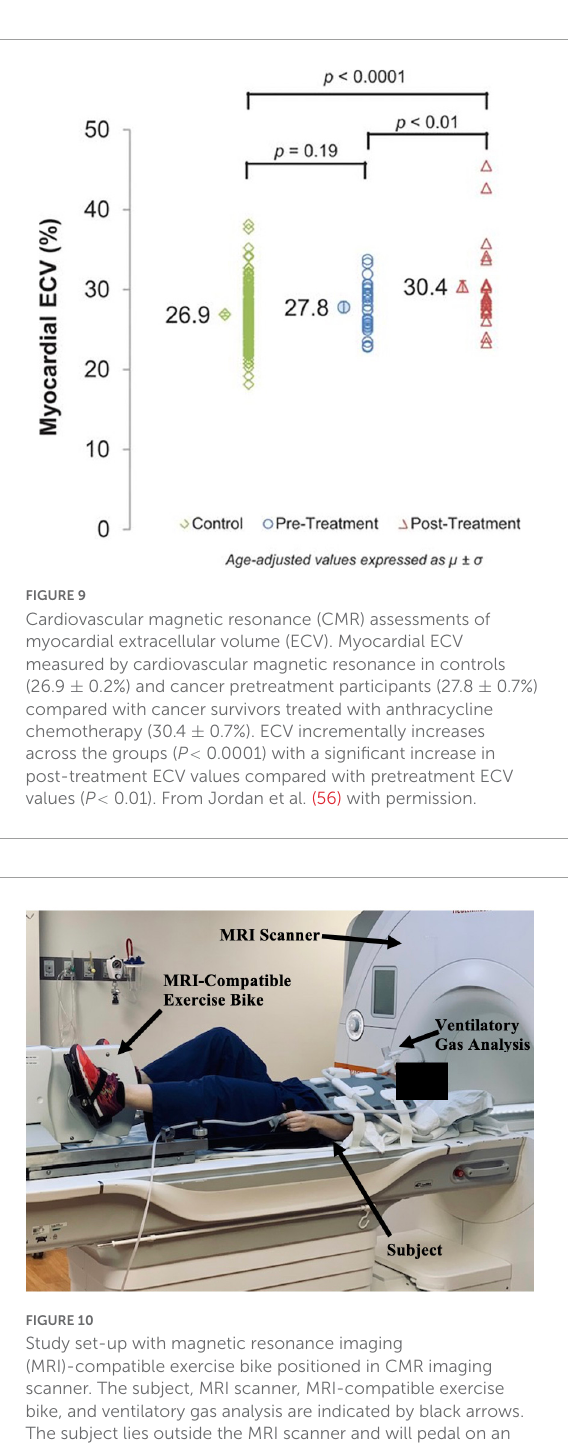
FIGURE10 Study set-up with magnetic resonance imaging (MRI)-compatible exercise bike positioned in CMR imaging scanner. The subject, MRI scanner, MRI-compatible exercise bike, and ventilatory gas analysis are indicated by black arrows. The subject lies outside the MRI scanner and will pedal on an exercise bike as they move through the scanner. Ventilatory gas analysis is simultaneously performed while a cardiac MRI is